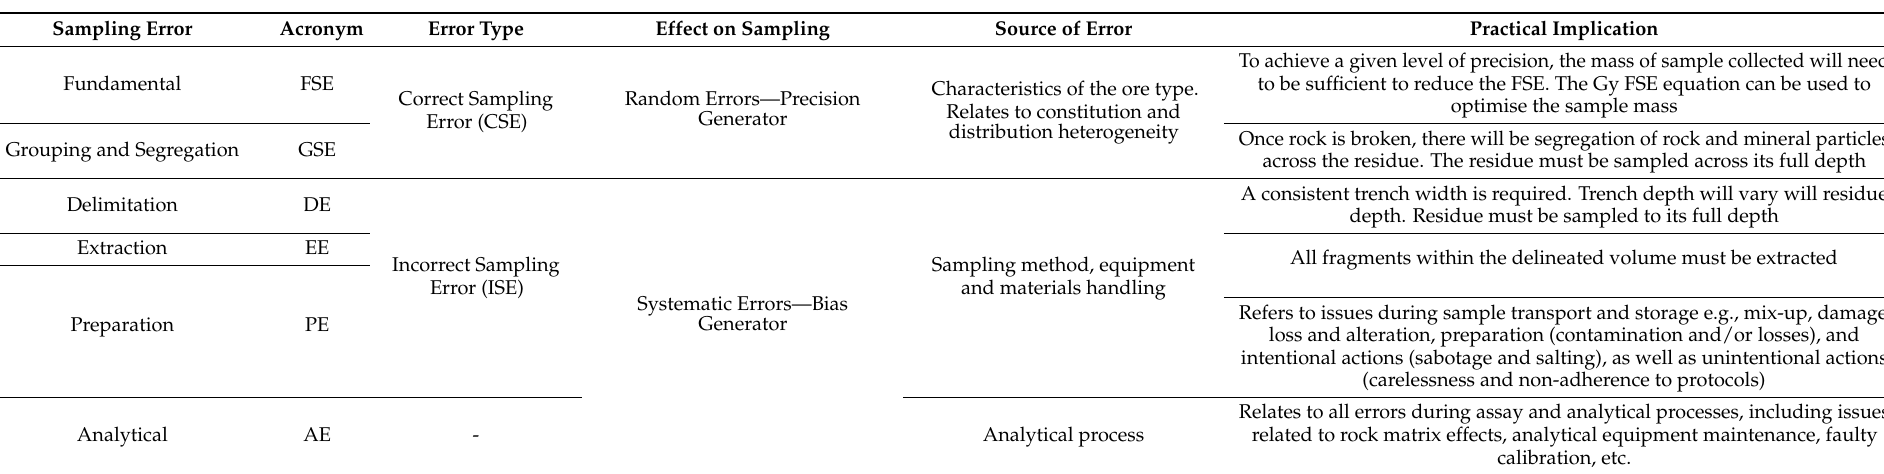
Table 2. TOS sampling errors during drive residue